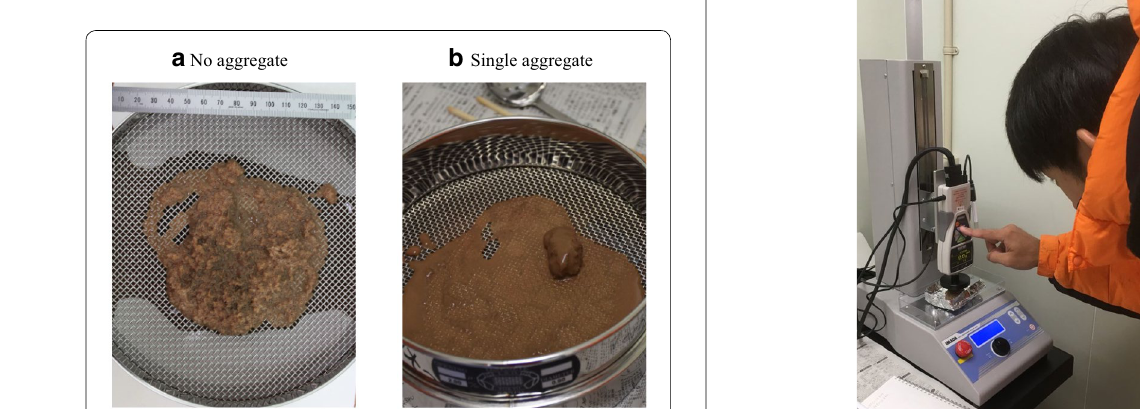
Fig. 3 Photograph of the compression machine. Experimental apparatus used to measure the compressive mechanical properties of the